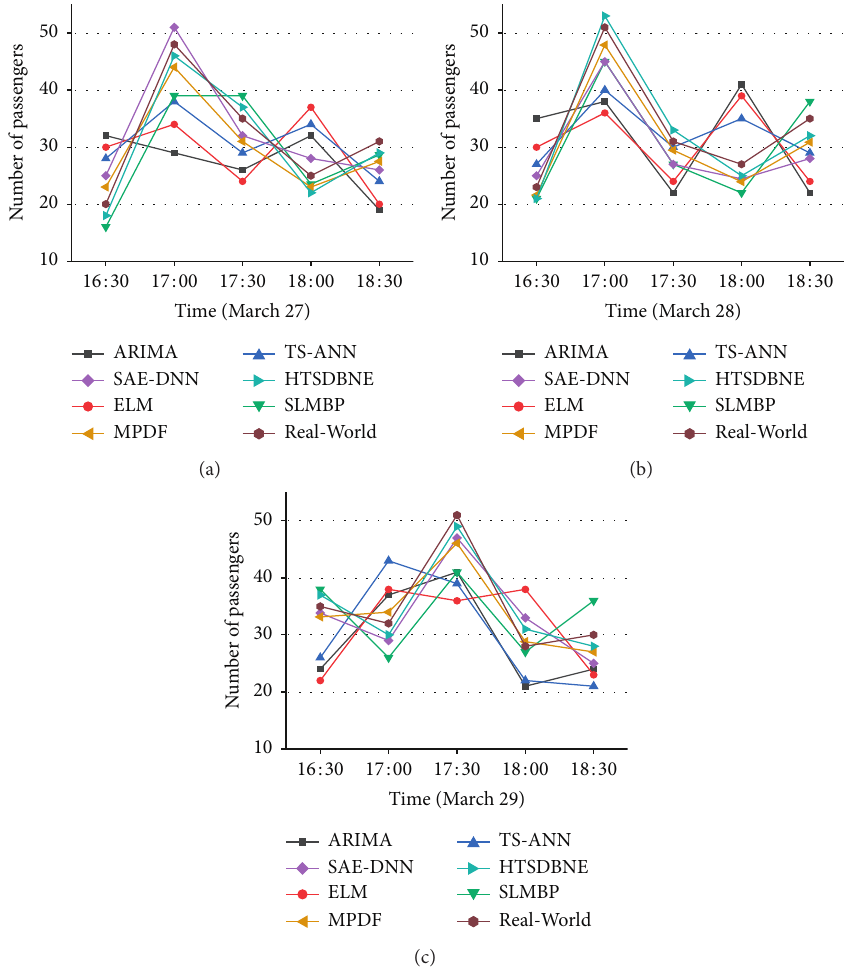
Figure 16: Comparison between HTSDBNE and other models in the evening peak hours of working days (station 7 of line 28).